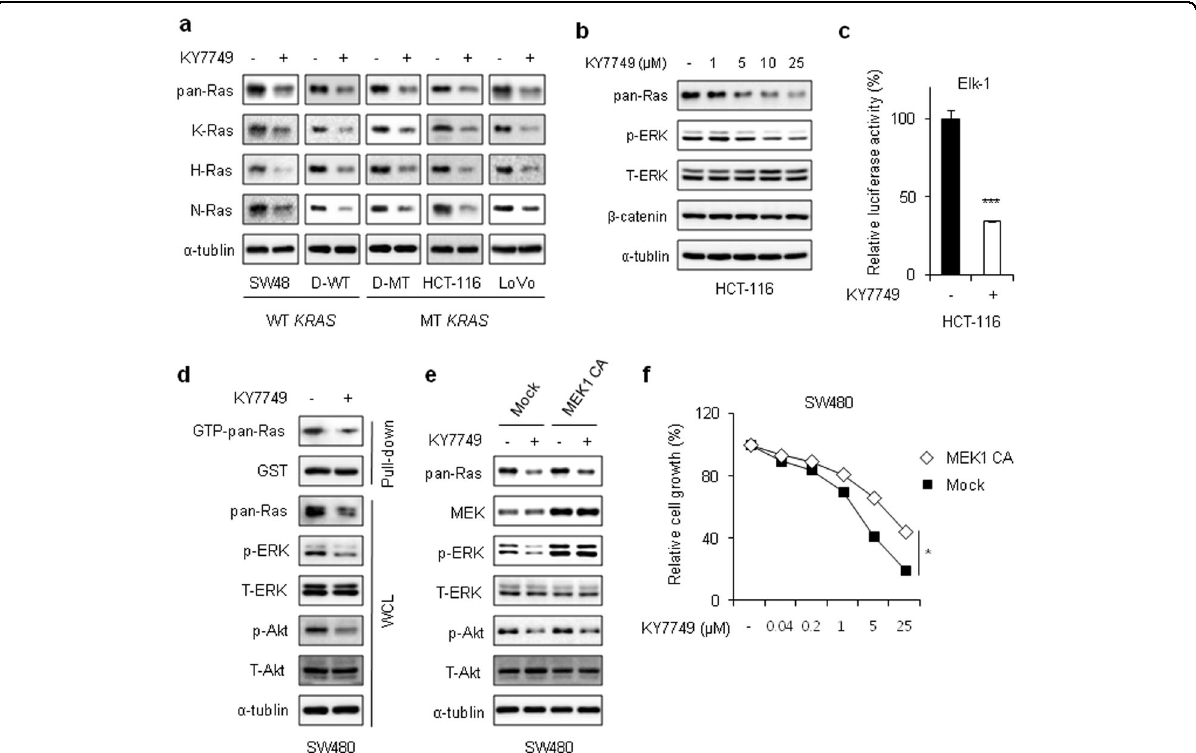
Fig. 3 The effects of KY7749 on Ras degradation and its dependence on Wnt/ β -catenin signaling. a Immunoblot analysis of SW48, D-WT, D- MT, HCT-116, and LoVo cells treated with 25 μ M of KY7749 for 24 h. b Immunoblot analysis of HCT-116 cells treated with various doses of KY7749 for 24 h. c Elk-1 reporter assay in HCT-116 cells treated with 25 μ M KY7749 for 24 h. The effect of KY7749 on ERK activity was detected based on the activity of an Elk-1 reporter construct. d SW480 cells were treated with 25 μ M KY7749 for 24 h. GTP-bound Ras was measured as described in the Materials and Methods by pull-down of GTP-bound Ras and subsequent monitoring of phosphorylation of the Raf-1 Ras-binding domain (GST-RBD). e Immunoblot analysis of SW480 CRC cells overexpressing the MEK1 CA construct and treated with 25 μ M KY7749 for 24 h. f MTT assays in MEK1 CA- overexpressing SW480 CRC cells cultured with DMSO (control) or various doses of KY7749 for 96 h (mean± SD, n = 3). Relative cell proliferation was normalized to DMSO-treated controls. WCLs or pull-down samples were immunoblotted with antibodies against the indicated proteins ( a – b , d – e